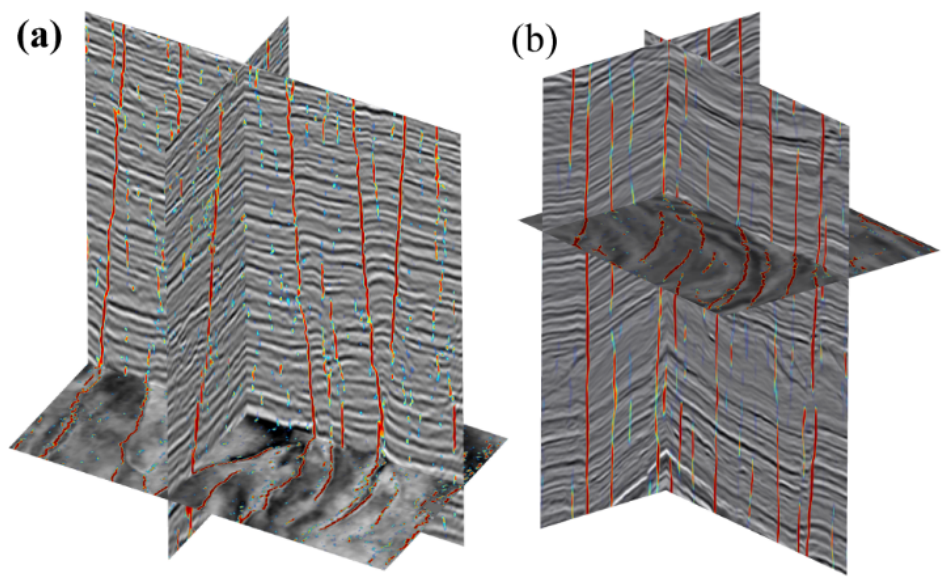
Figure 9. 3D view of fault detection results for Data1 ( a ) and Kerry ( b ).